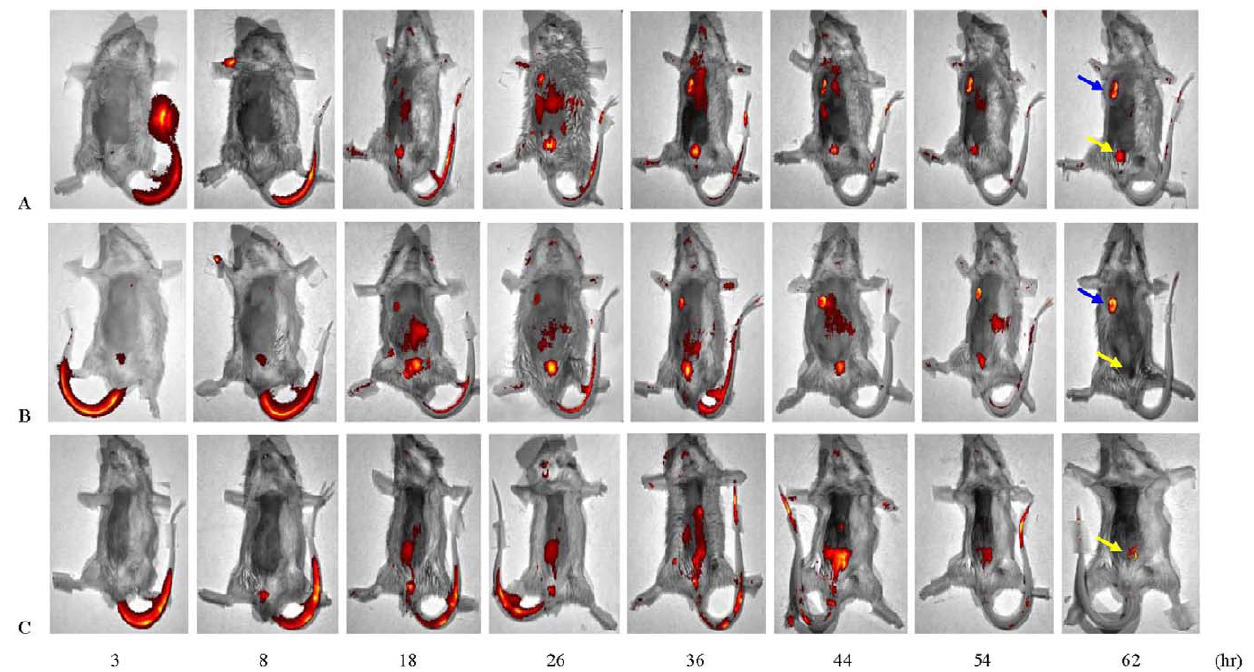
Figure 6. Monitoring of the targeting of EGF-SEA to solid tumors by invivo imaging of mice. LSS670-labeled EGF-SEA proteins (125 pmol) were injected i.v. into mice bearing tumors (A and B) and un-inoculated mice as control (C). Movement of labeled EGF-SEA proteins was observed using in vivo fluorescence imaging with the IVIS Kinetic imaging system. Blue and yellow arrows indicated the tumor and bladder positions.